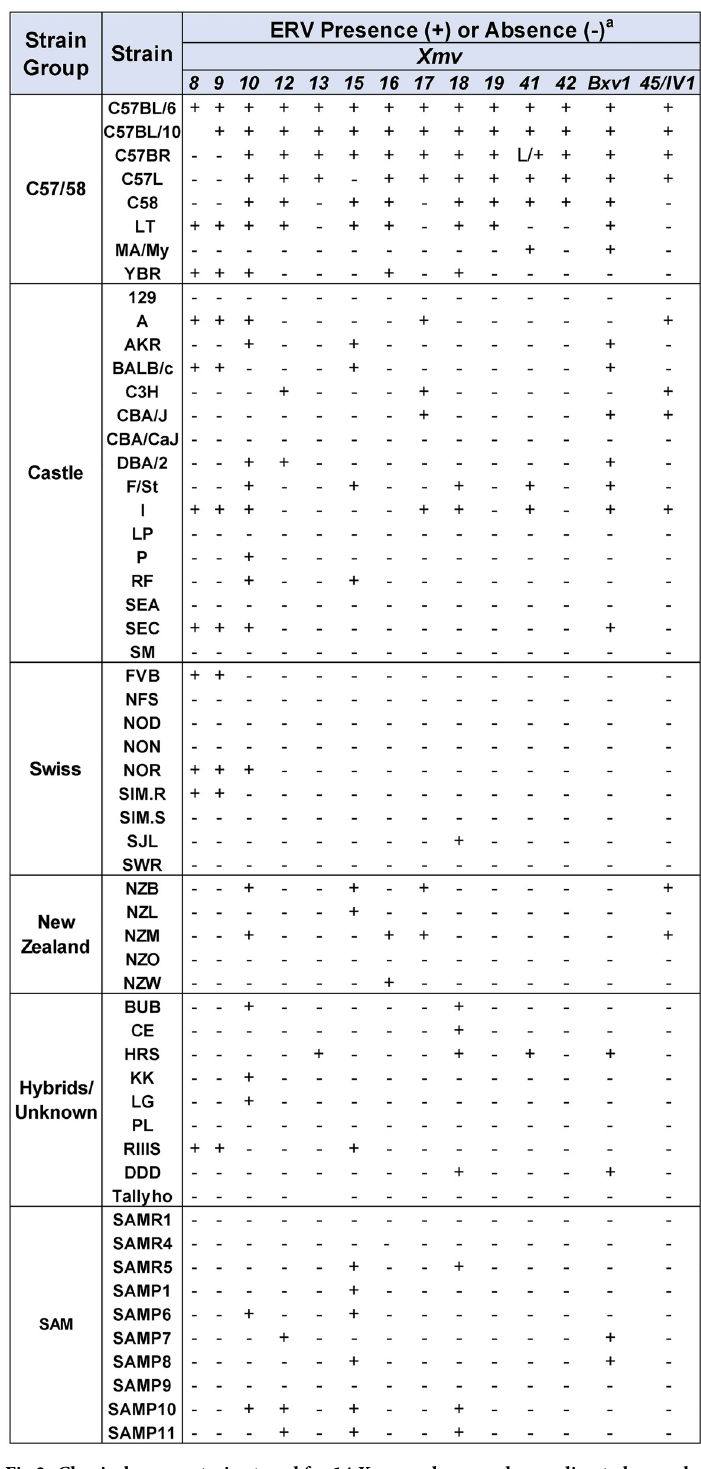
PLOS ONE | https://doi.org/10.1371/journal.pone.0219576 July 10,